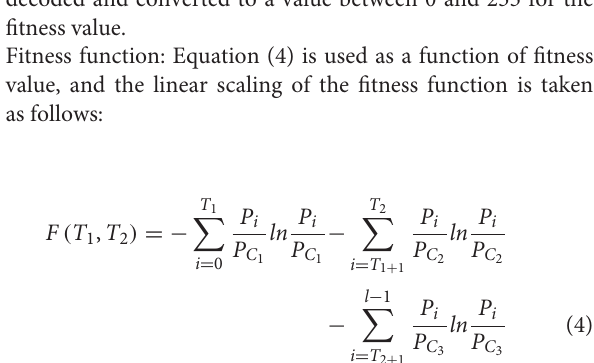
represent the segmentation threshold T 2 . The number of seedlings affects the fitness calculation of each generation. The initial generation quantity should be set reasonably. After a lot of simulation, the number of pepper seedlings is set to 21, and the maximum number of breeding algebras is set to